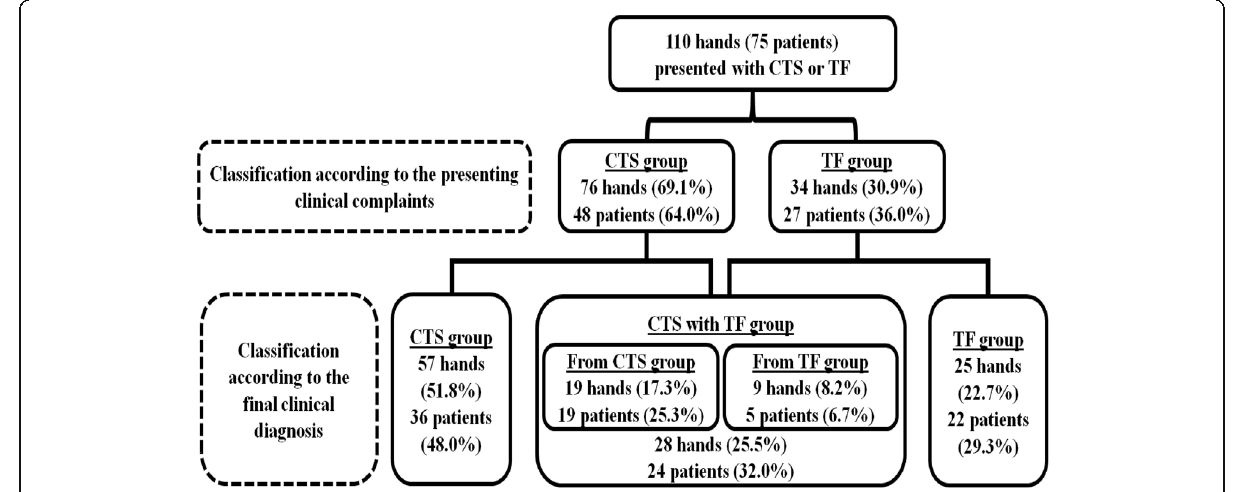
Fig. 6 Distribution of patients according to the final clinical diagnosis into three groups. There were seven patients who had bilateral carpal tunnel syndrome (CTS) in which there was trigger finger (TF) in one hand and not in the other (these seven patients were mentioned twice: once with CTS group and the other time with CTS with TF group). CTS , carpal tunnel syndrome; TF , trigger